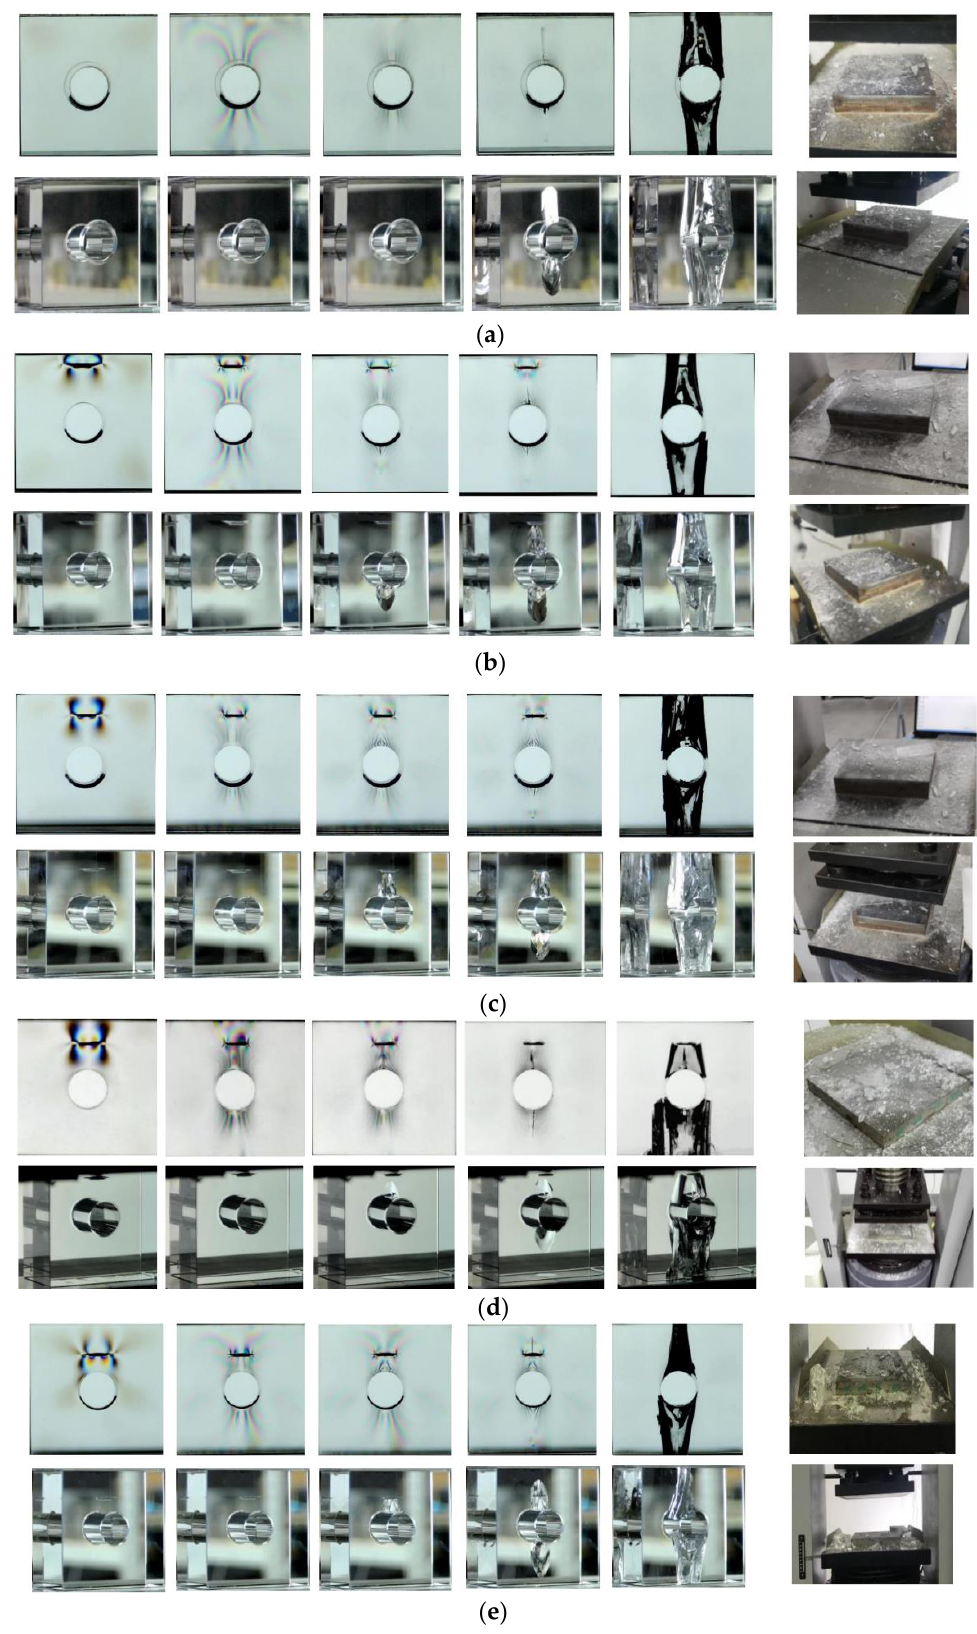
Figure 5. Crack propagation processes of the orifice specimen. ( a ) A0; ( b ) B0.5; ( c ) B1; ( d ) B1.5; ( e ) B2.